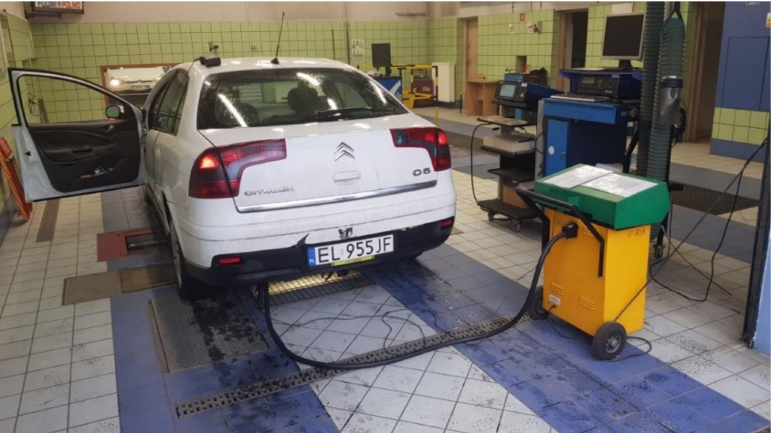
Figure 1. Measurement of fuel consumption and emissions of the diesel engine applied in the vehicle Citroen C5 II 1.6 HDI 2008 100 kW in the Diagnostic Station in the Vocational Automotive High School of Lodz in